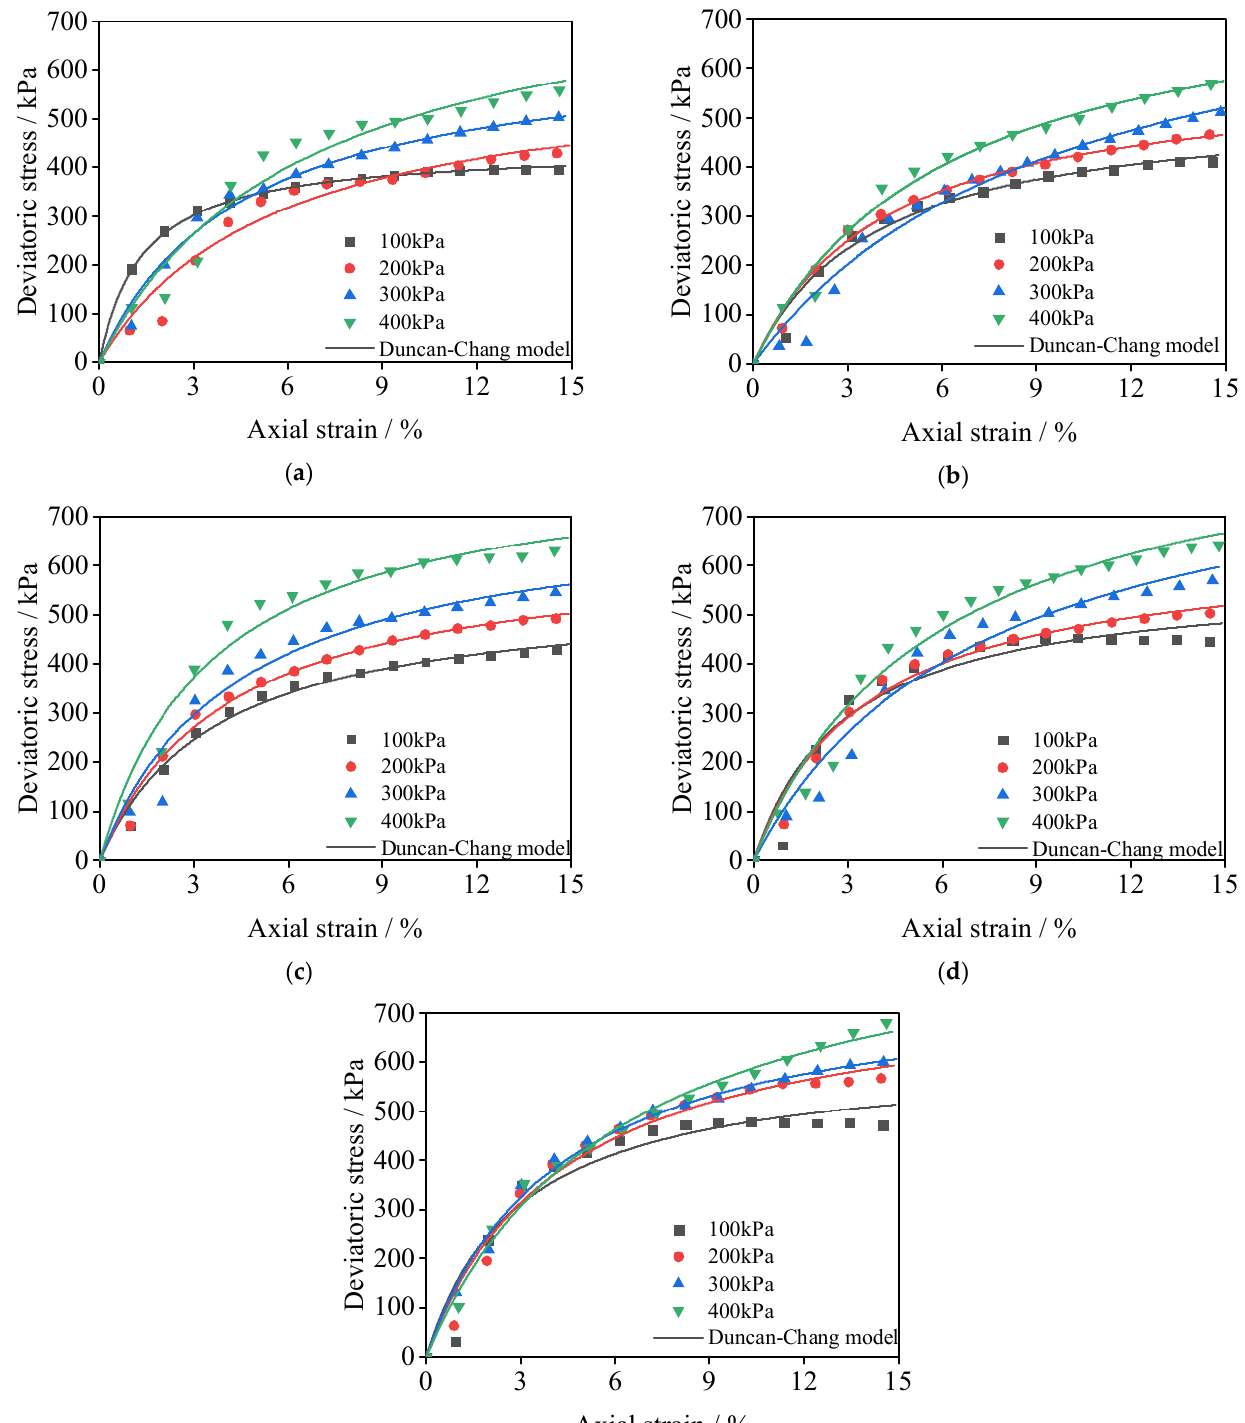
Figure 7. Comparison between Duncan–Chang model and measured results. ( a ) SCSC0 ( b ) SCSC4 ( c ) SCSC6 ( d ) SCSC8 ( e ) SCSC10.